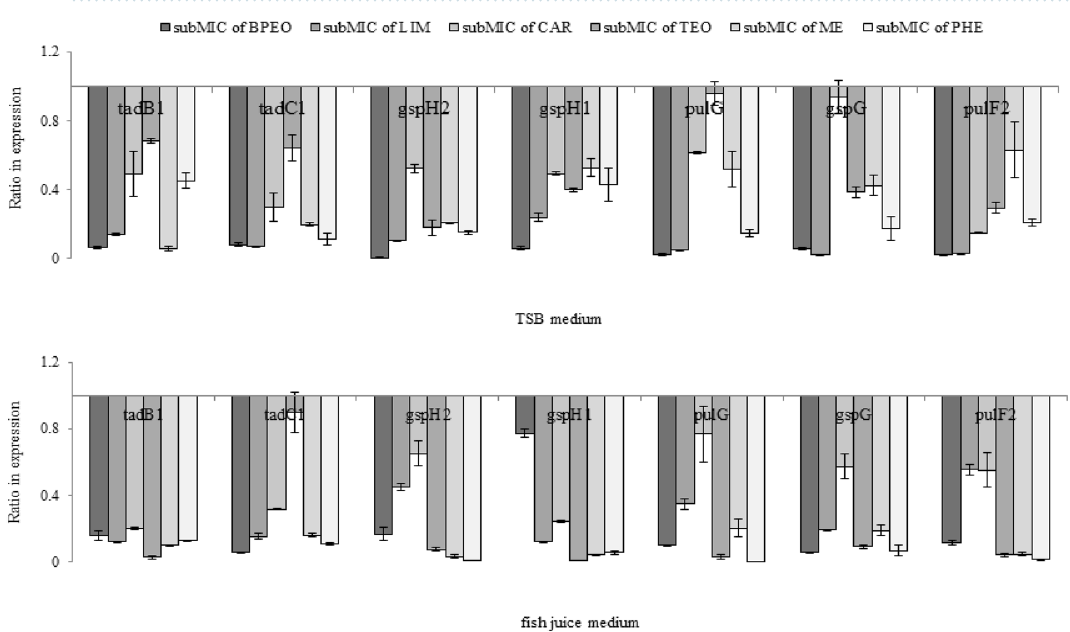
Figure 9. Ratio in expression of type II secretion system genes in P. psychrophila KM02 grown on modified TSB and fish juice medium supplemented with subMICs of black pepper (BPEO) and tarragon essential oils (TEO), limonene (LIM), β-caryophyllene (CAR), methyl eugenol (ME), and β-phellandrene (PHE). Values are calculated from three independent replicates. Error bars represents standard deviation values. The statistically differences in expression was provided by Tukey’s test after ANOVA analysis (F = 41.32, p < mRNA levels of T2 secretome genes in KM02 cells were evaluated. For RT–qPCR experiments, KM02 cells were treated with subMICs of BPEO, TEO and major compounds of the oils both in vitro and in fish juice medium mimicking the seafood ecosystem. Based on bioinformatic analysis of the KM02 genome, the following 7 potential genes responsible for T2SS function were identified: pulG and gspG genes encoding pseudopilins PulG and GspG respectively; tadB1 and tadC1 genes encoding integral proteins of the inner membrane involved in the general secretion pathway (GSP); gspH2 and gspH1 genes encoding proteins required for energy-related secretion from the periplasm; and pulF gene involved in lipase export (Supplementary Table S3). As presented in Fig. 9, regardless of the agents used, the expression levels of most T2SS genes were inhibited to relative levels of between 0.9 and 0.02 that of control. Under in vitro conditions the most efficient treatments for downregulation of the expression of T2SS genes were BPEO and LIM, with relative transcript levels ranging from 0.2 to 0.02 that of control. In fish juice medium the highest reductions in the mRNA levels of T2SS genes were recorded for TEO and its singular components (i.e.,